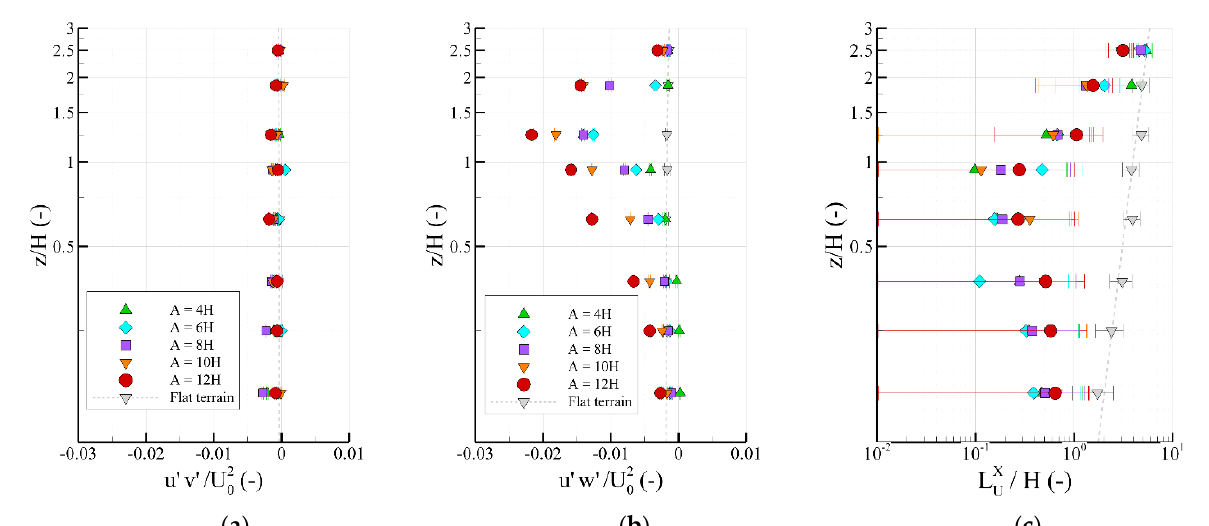
Atmosphere 2021 , 12 , x FOR PEER REVIEW Figure 6. Semilogarithmic vertical profiles of the normalized horizontal ( a ) and vertical ( b ) turbulent fluxes above the valley midpoints; logarithmic vertical profiles of the normalized longitudinal integral length scales above the valley midpoints ( c ).